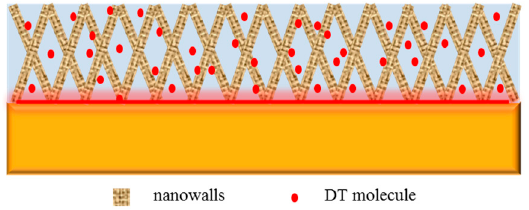
Figure 12. Schematic of networks on H 3 PO 4 -treated copper surface with 1-dodecanethiol SAM.